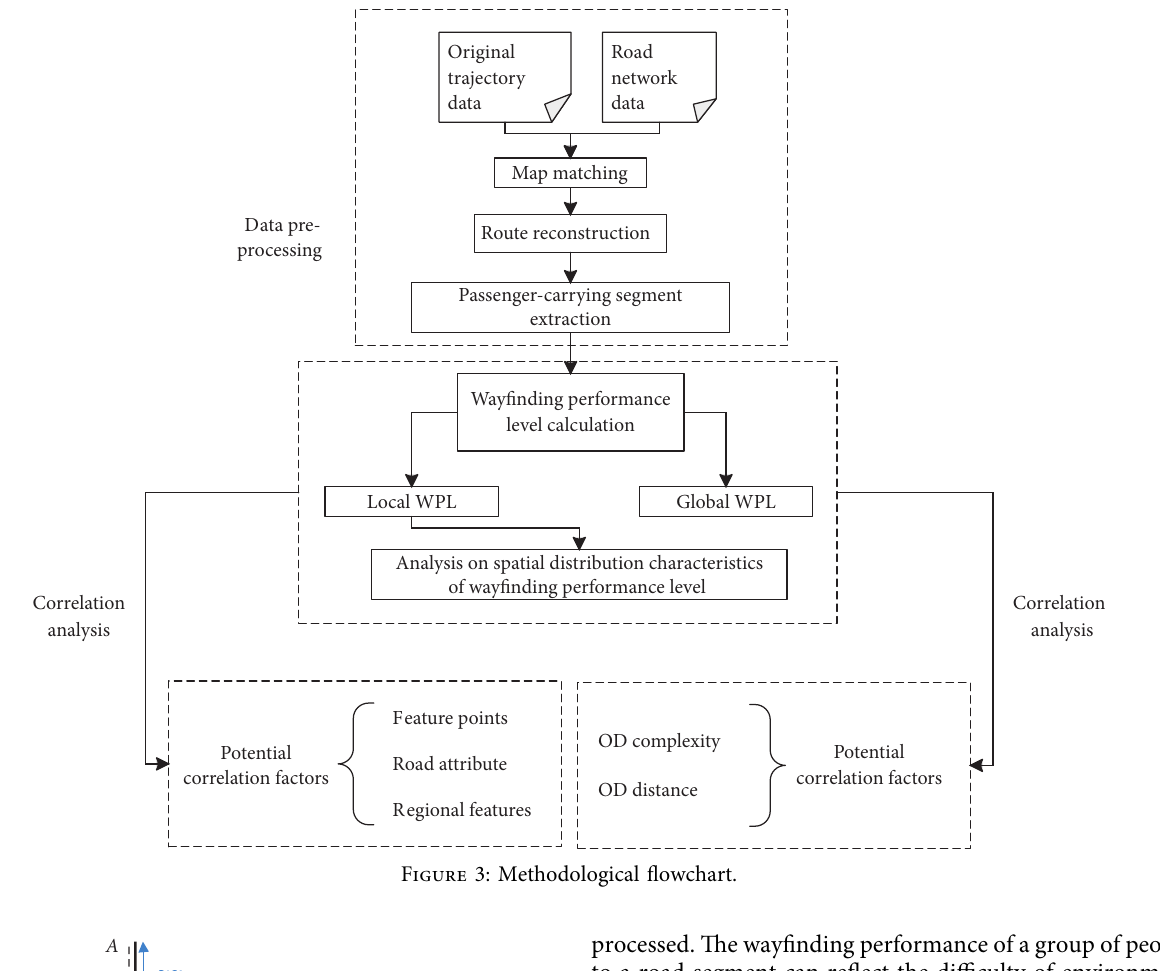
Figure 3: Methodological